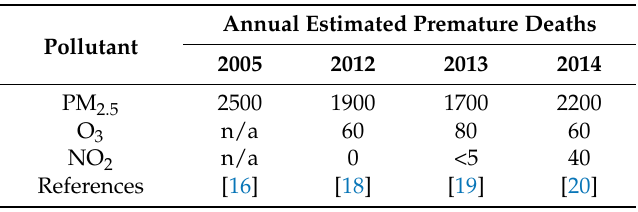
Table 1. European Environmental Agency (EEA) estimates for premature deaths related to ambient air pollution exposure in